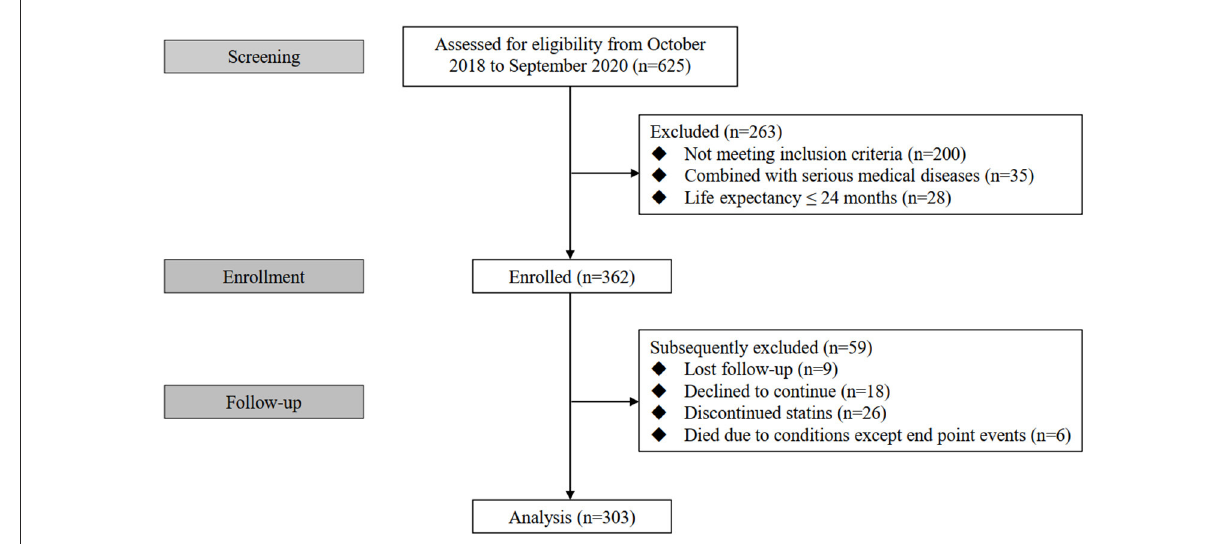
FIGURE1 Flow diagram of the